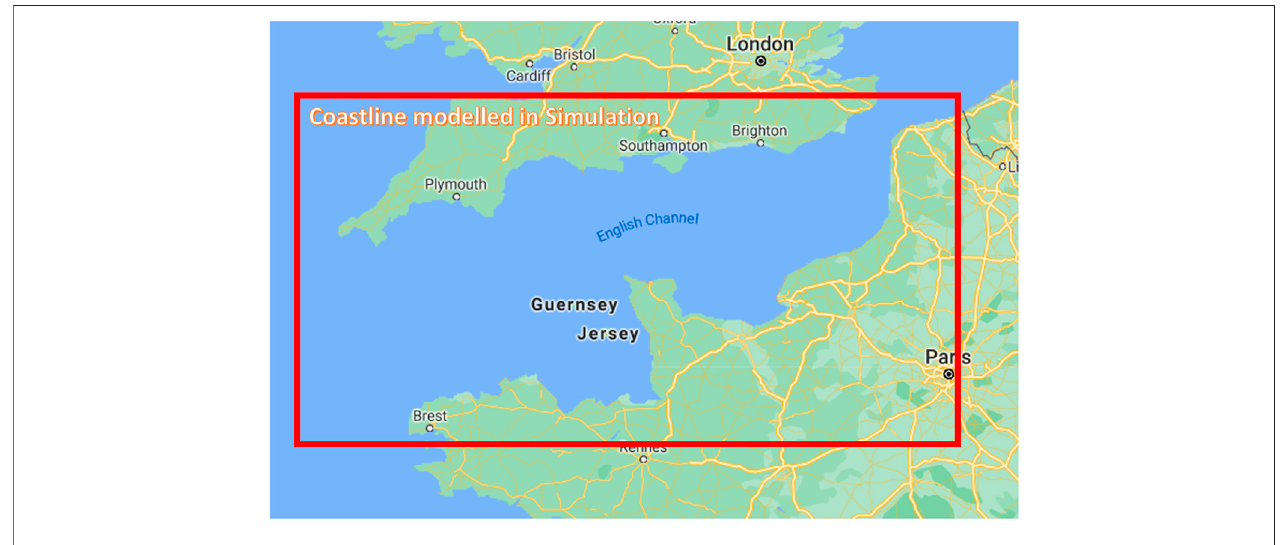
FIGURE 1 | Alderney Race location Map (Source Google).